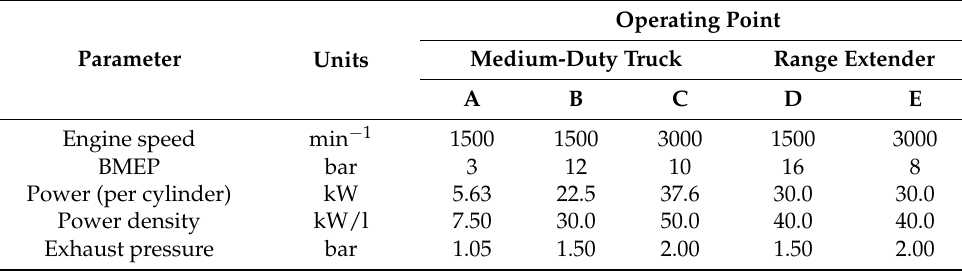
Table 4. Engine operating points for medium-duty truck and range extender applications.